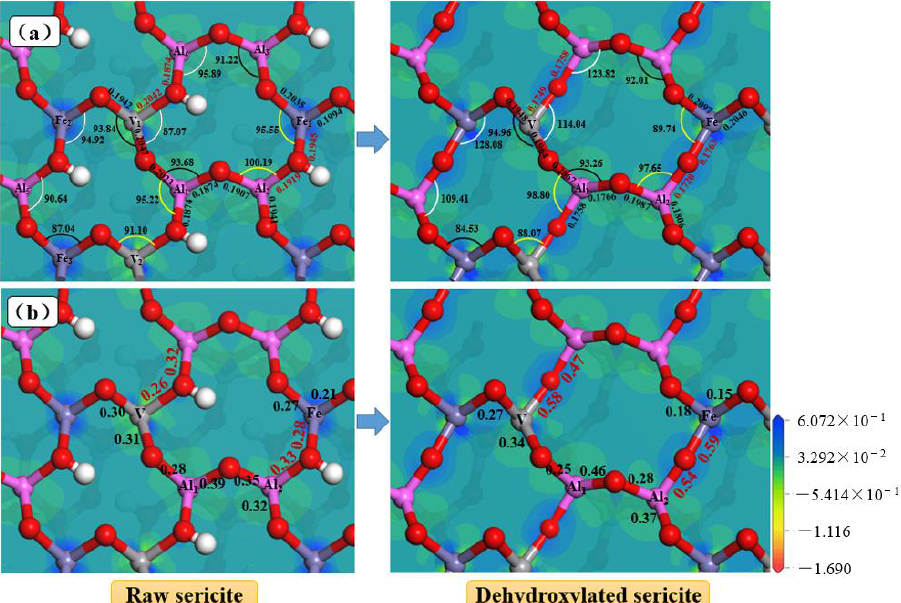
Figure 11. Parameters of chemical bonds in the sericite (0 0 1) surface (bond angle and bond length ( a ), Mulliken’s overlap population ( b )).